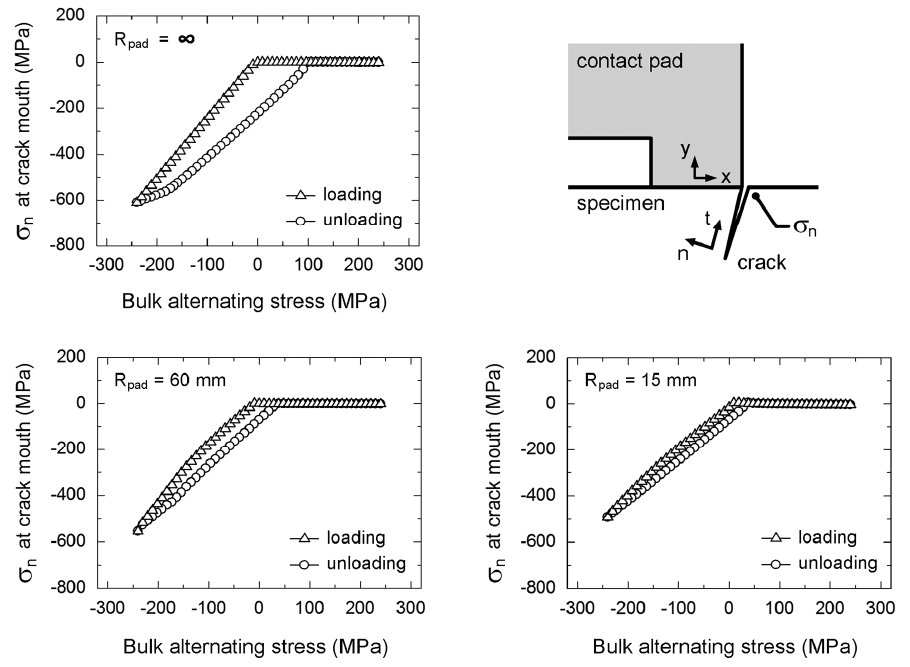
Figure 15. Stresses near the crack mouth of a 80 µ m fretting fatigue crack tested at a stress amplitude of 300 MPa.